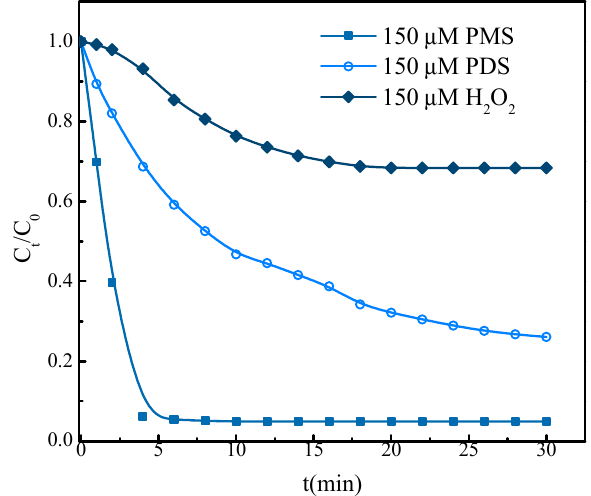
Figure 1. The decolorization of Orange II in different peroxides systems ([Fe 3+ ] 0 = 100 µM, [Orange II] 0 = 50 µM, [H 2 O 2 ] 0 = [PDS] 0 = [PMS] 0 = 150 µM, [oxalate] 0 = 80 µM, under UVA irradiation, λ irr. = 365 nm, pH = 3).